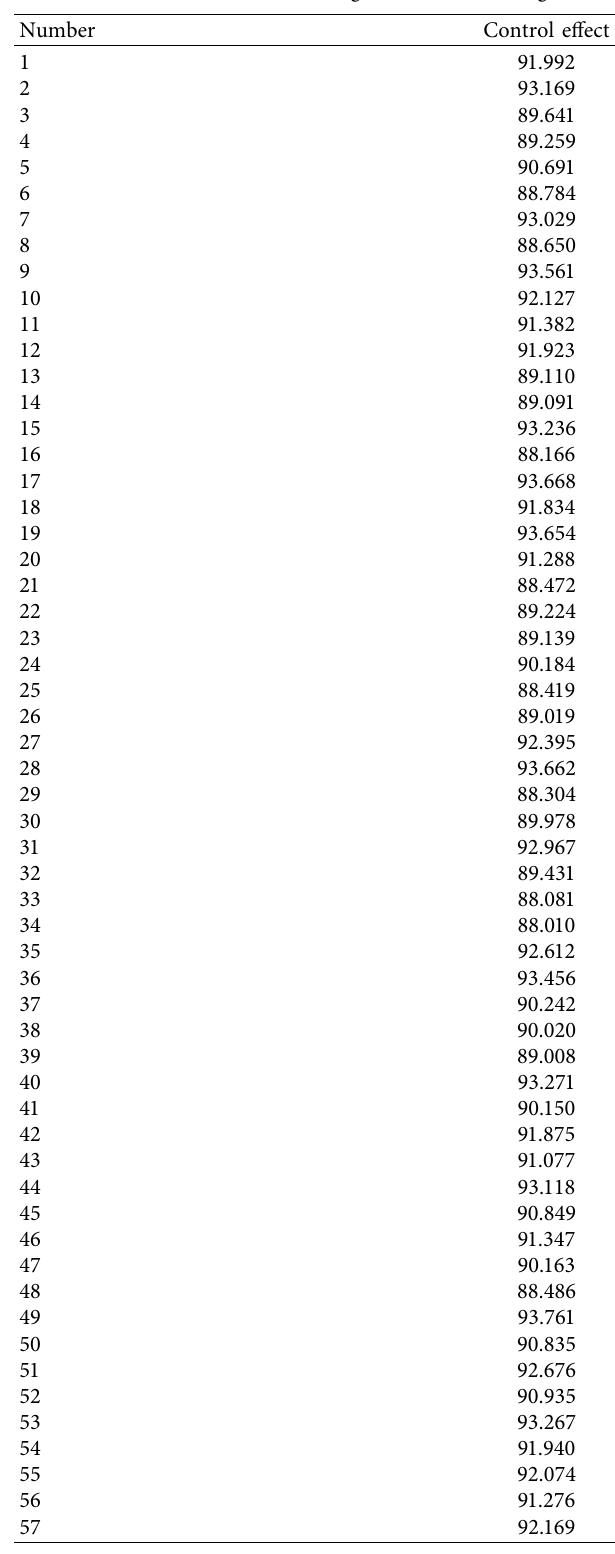
Table 2: The control effect of the UAV intelligent control system based on machine vision and multiagent